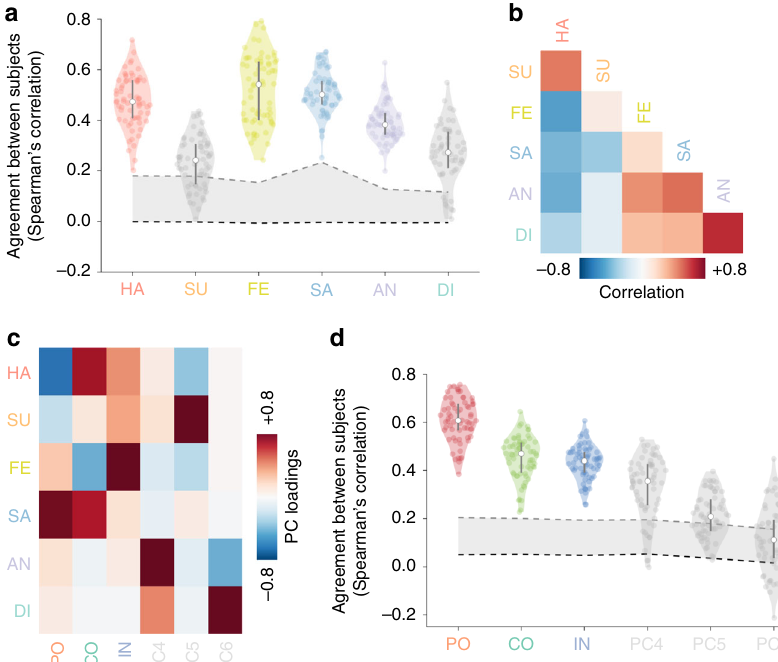
Fig. 1 Emotion ratings. a Violin plots show the agreement between subjects (Spearman ’ s ρ coef fi cient) of the six basic emotions. White circular markers indicate mean correlation across subjects and black bars denote 25th and 75th percentile of the distribution ( n = 66 subject pairings). Gray shaded area represents the null distribution of behavioral ratings and dashed lines the mean and 95th percentile of the null distribution. b Correlation matrix showing Spearman ’ s ρ values for pairings of basic emotions. c Principal component analysis: loadings of the six principal components. Explained variance was 45% for polarity, 24% for complexity and 16% for intensity. d Violin plots show the agreement between subjects (Spearman ’ s ρ coef fi cient) of the six principal components. White circular markers indicate mean correlation across subjects and black bars denote 25th and 75th percentile of the distribution ( n = 66 subject pairings). Gray shaded area represents the null distribution of behavioral ratings and dashed lines the mean and 95th percentile of the null distribution. HA happiness, SU surprise, FE fear, SA sadness, AN anger, DI disgust, PC principal component, PO polarity, CO complexity, IN